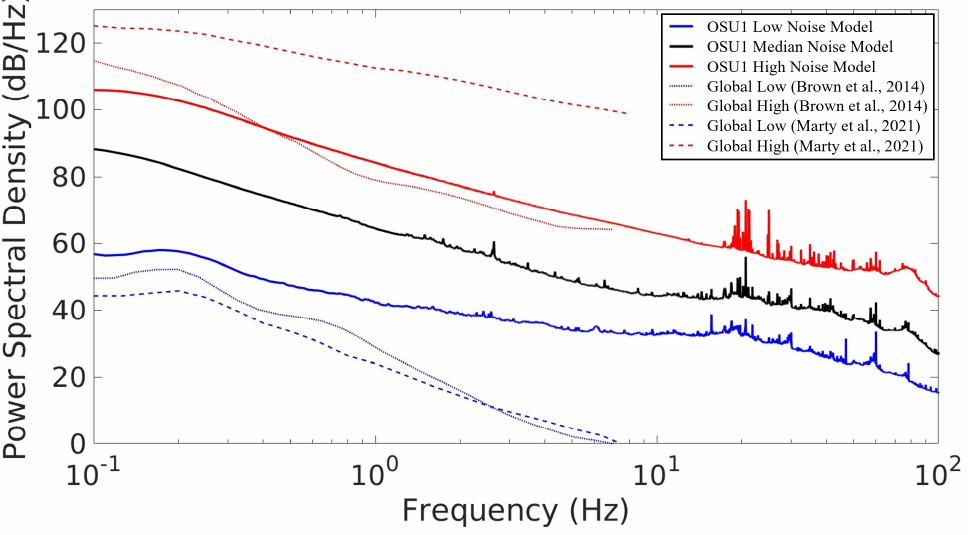
Figure 5. Power spectral density plot showing the OSU1 noise models (low, median, and high). These noise models are compared with the established global low and high noise models [34,35].